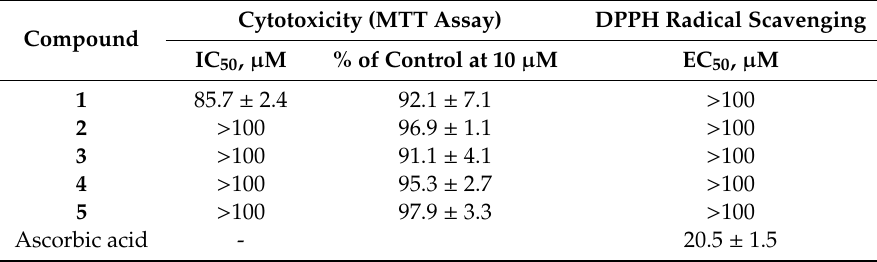
Table 1. Cytotoxic and radical scavenging activities of compounds 1 – 5